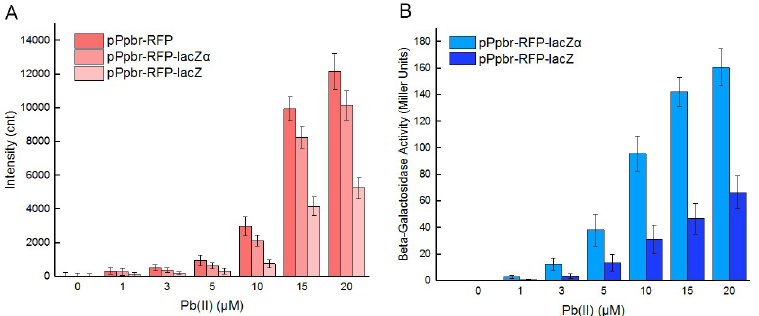
Fig 6. Monocistronic RFP, bicistronic RFP-lacZ α , and bicistronic RFP-lacZ reporter strains in response to lead (II). The fluorescent (A) and enzymatic (B) response of Top10/pPpbr-RFP, pPpbr-RFP-lacZ α , and pPpbr-RFP-lacZ to different concentrations of Pb(II) plus 0.1 mM IPTG after 4 h incubation at 37˚C. Data are mean ± SD from three independent experiments each from three independent cultivations.